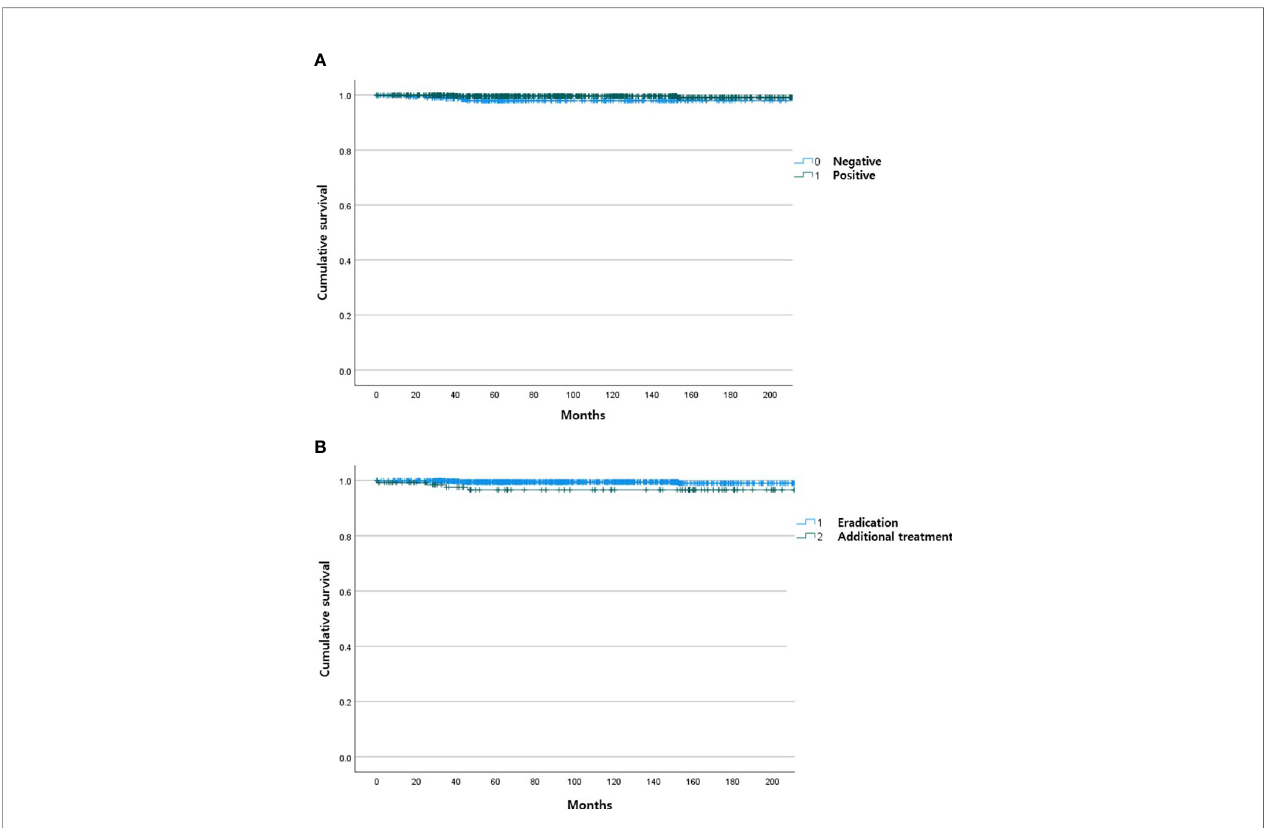
FIGURE 3 | Kaplan Meier curves of gastric MALT lymphoma patient survival according to H pylori status (A) and type of treatment (B) .